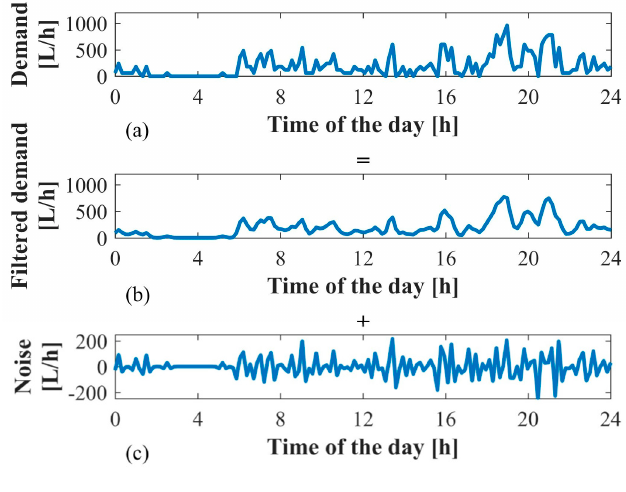
Figure 3. ( a ) Original and ( b ) filtered DHW demand, and ( c ) noise signal profiles for a selected